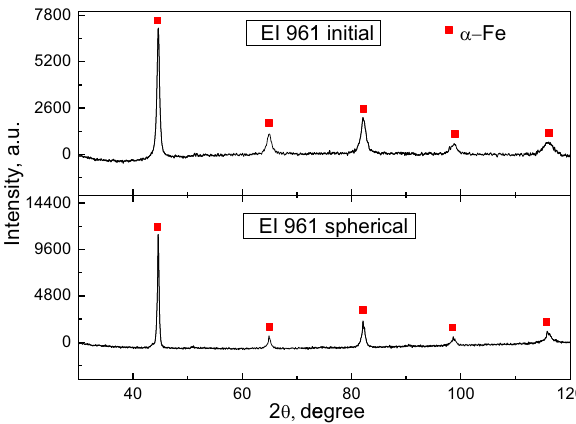
Figure 11: XRD patterns of initial and spherical powder after spheroidization.